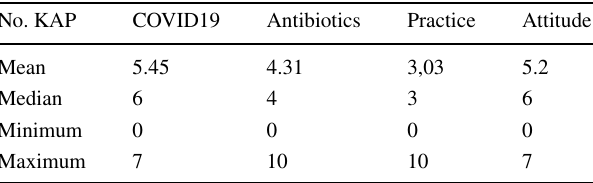
Table 3 Summary of KAP scales (COVID19, antibiotics use, preven- tive measures and attitude towards new norm) No.